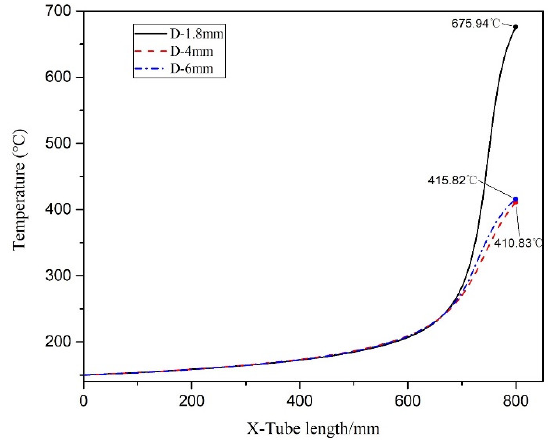
Figure 7. Temperature distribution cloud diagram of the axial section of the microreactor at different tube diameters under adiabatic conditions.